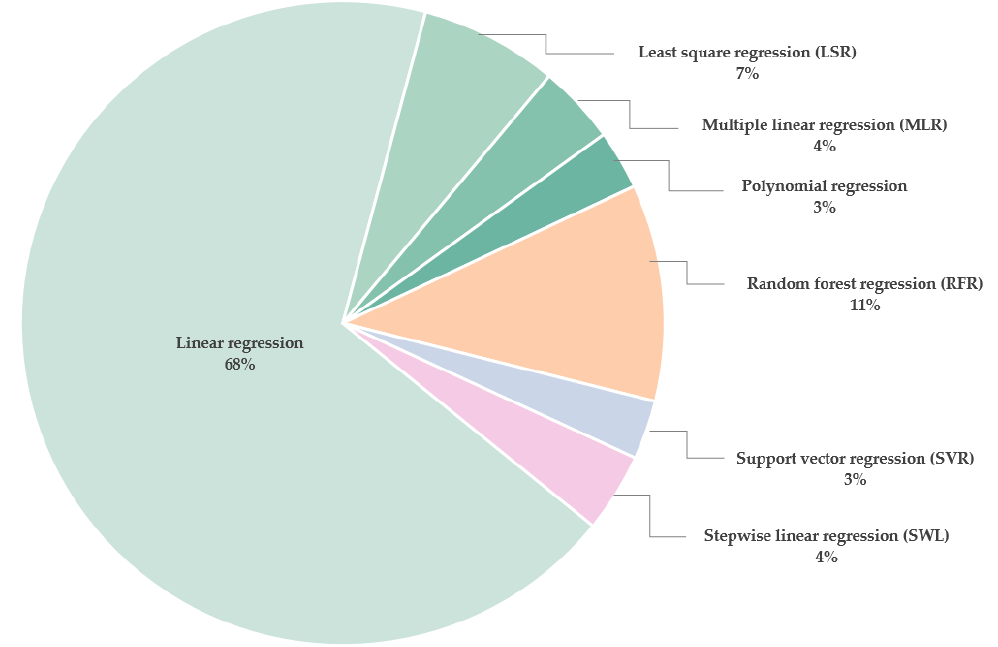
Figure 21. Regression models used in 101 studies.